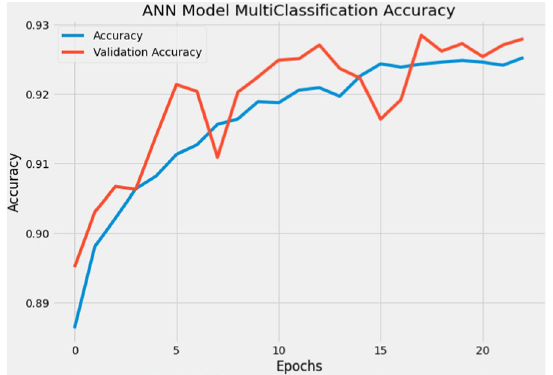
Fig. 9 Training and validation accuracy of LSTM